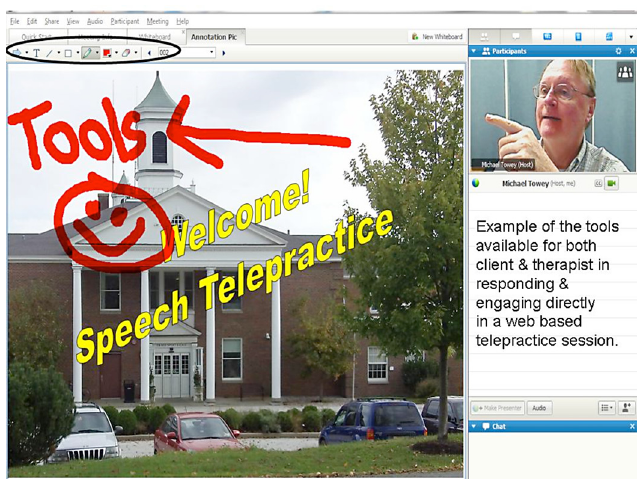
Figure 2: A screen shot of web-based telepractice that features authentic materials and an array of therapist/ client response